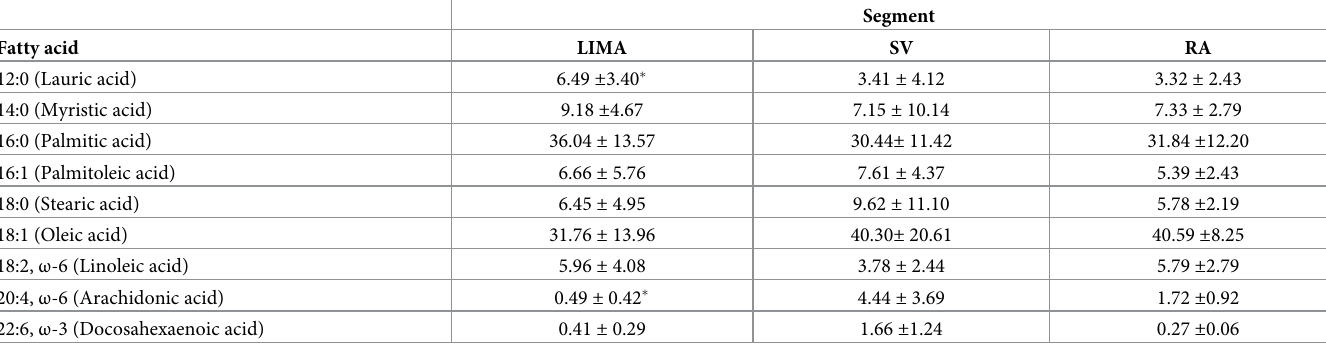
Table 2. Fatty acid composition (Mean% ± SD) of LIMA, SV, and radial artery in patients (n = 27) with CAD.